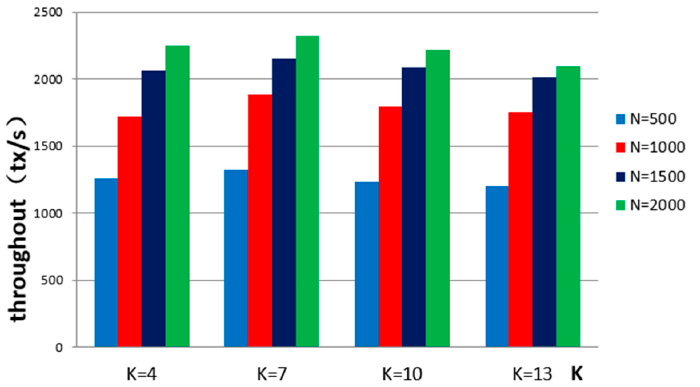
Figure 10. Throughput for various values of n and k.